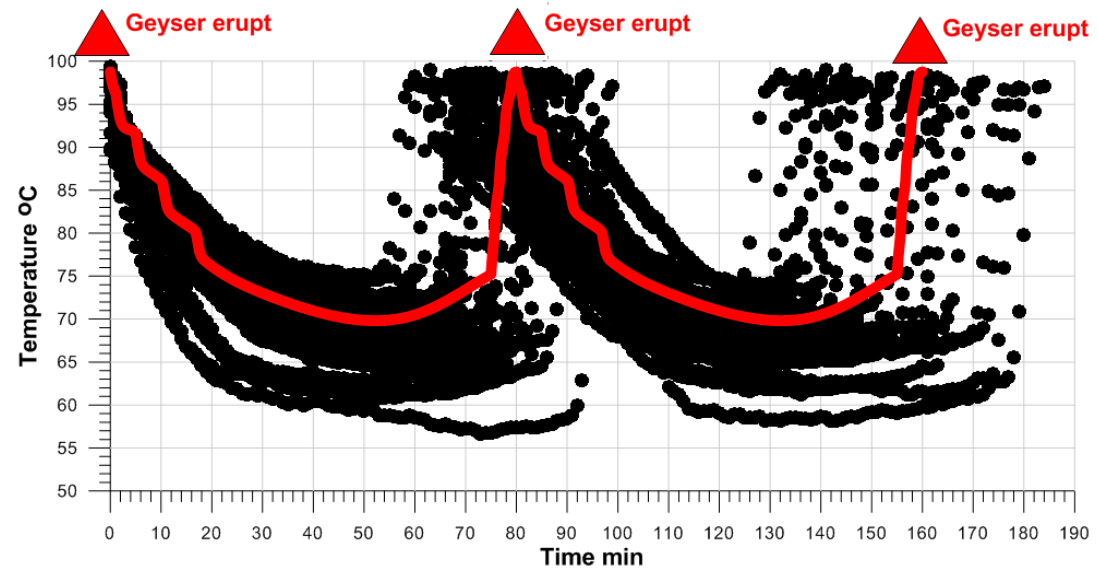
Figure 9. Modeling (run #9B, unknown parameters estimations are: q = 0.15 kg/s, h = 126 kJ/kg (water 30 °C), Q = 3 kg/s) of the transient bottom temperature (red line) in the Shaman geyser vs. the bottom temperature records (dots) obtained during the time period of observations from 24.07.2019 09:00 to 28.07.2019 15:00.